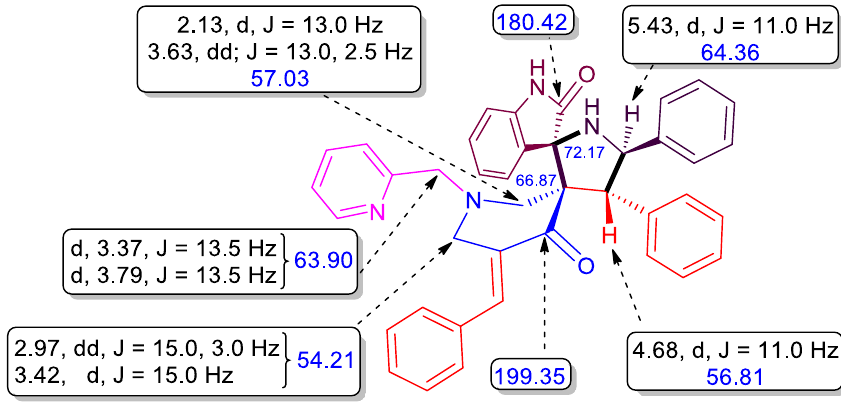
Figure 1. Selected 1 H and 13 C NMR chemical shifts of 8e.